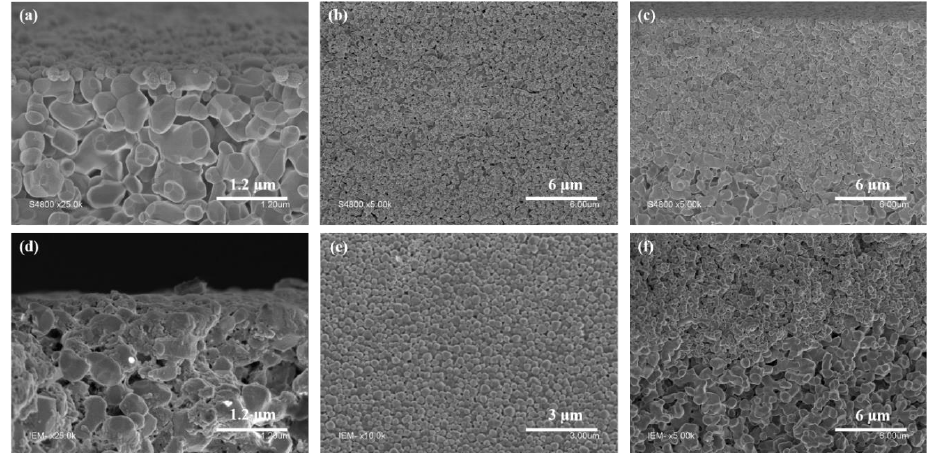
Figure 1. SEM images of ( a ) inner support layer cross-section, ( b ) inner support surface top view, ( c ) inner and intermediate support layer cross-section modified with UiO-PMAA- b -PMMA NPs; ( d ) inner support layer cross-section, ( e ) inner support surface top view, ( f ) inner and intermediate support layer cross-section modified with UiO-NH 2 -PMAA- b -PMMA.